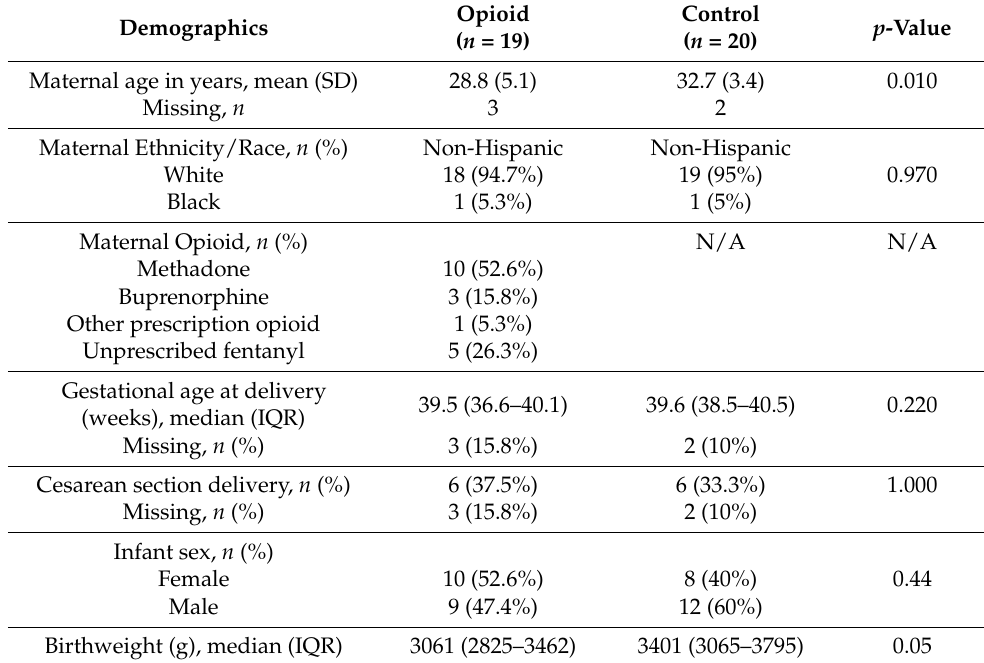
Table 1. Maternal and infant